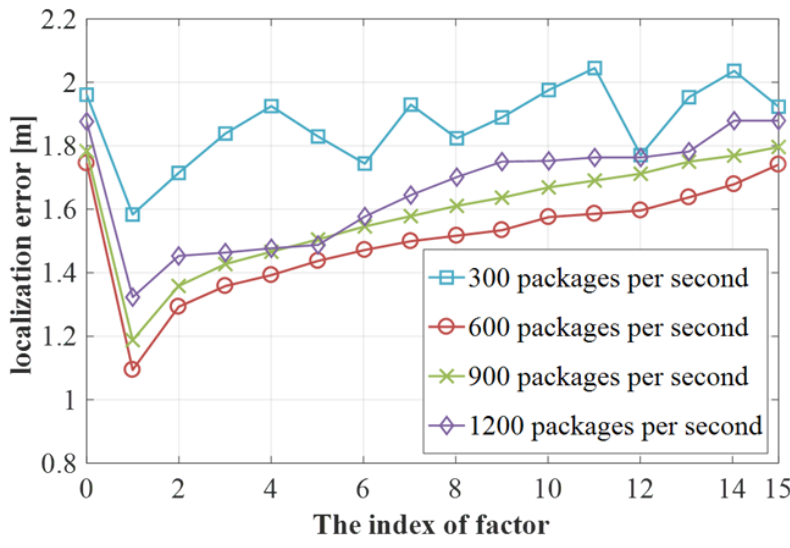
Figure 10. Impact of the clipping factor.